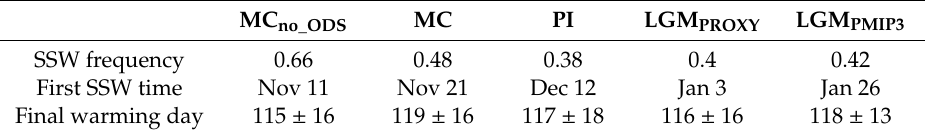
Table 2. SSW frequency (# / year), the time when the first SSW event appears, and the mean final warming day (January 1 is day 1) from the MC no_ODS , MC, PI, LGM PROXY , and LGM PMIP3 simulations. The standard deviation of the final warming day follows the ±